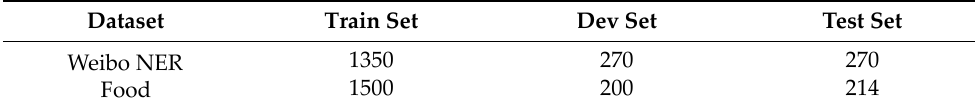
Table 1. Dataset segmentation statistics.